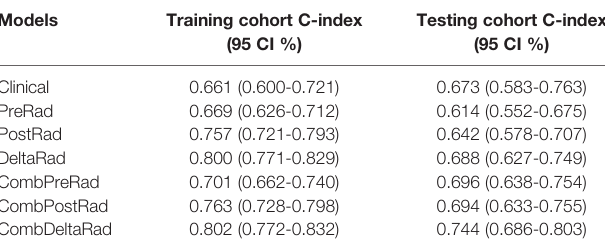
TABLE 2 | PFS prediction performance of various models.